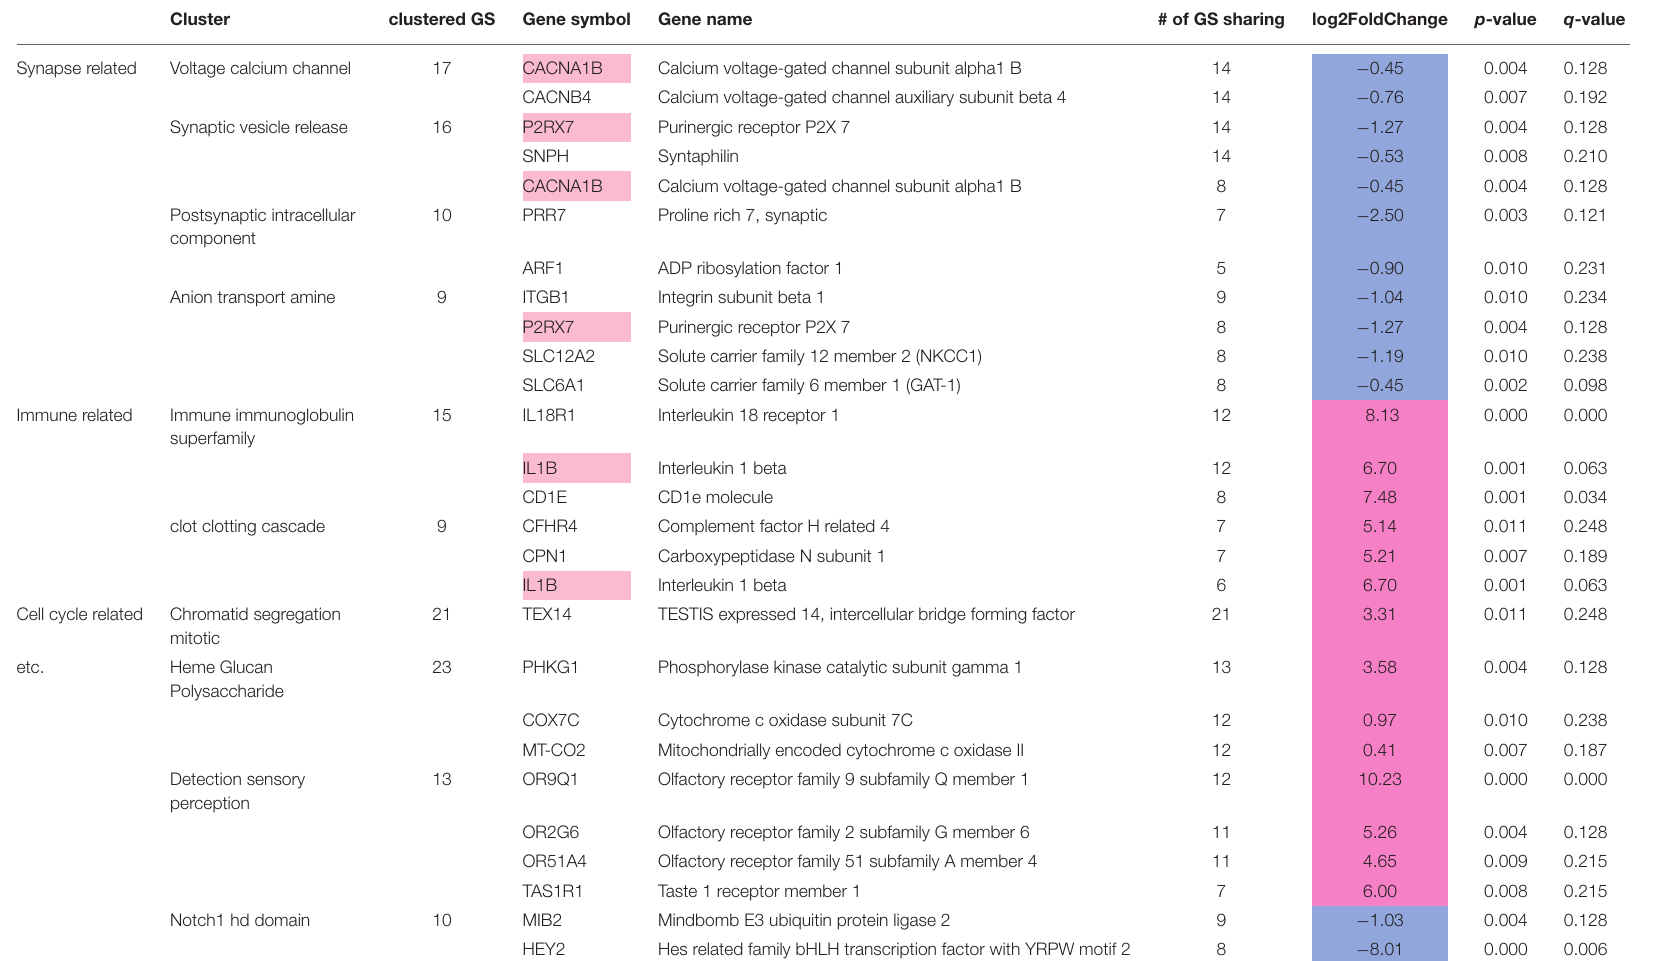
TABLE 5 | Twenty-four differentially expressed leading edge genes.